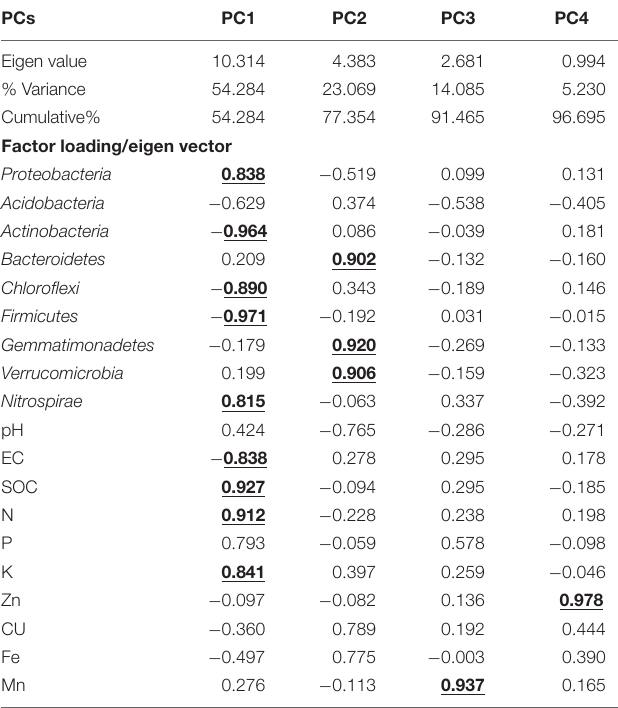
TABLE 4 | Principal components (PC) and component loadings extracted from different soil properties and microbial phyla; underlined component loadings were used to interpret the